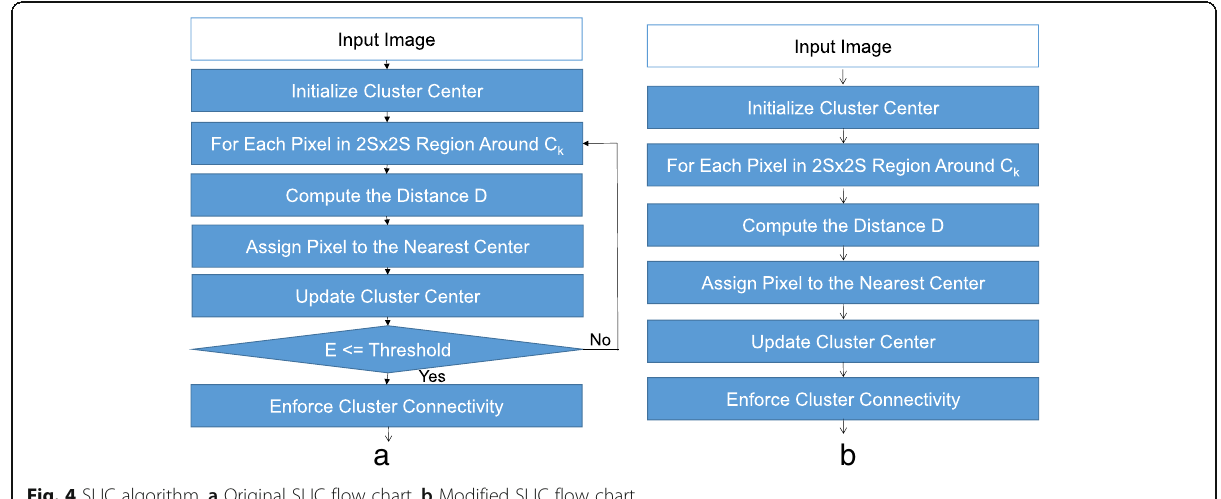
Fig. 4 SLIC algorithm. a Original SLIC flow chart. b Modified SLIC flow